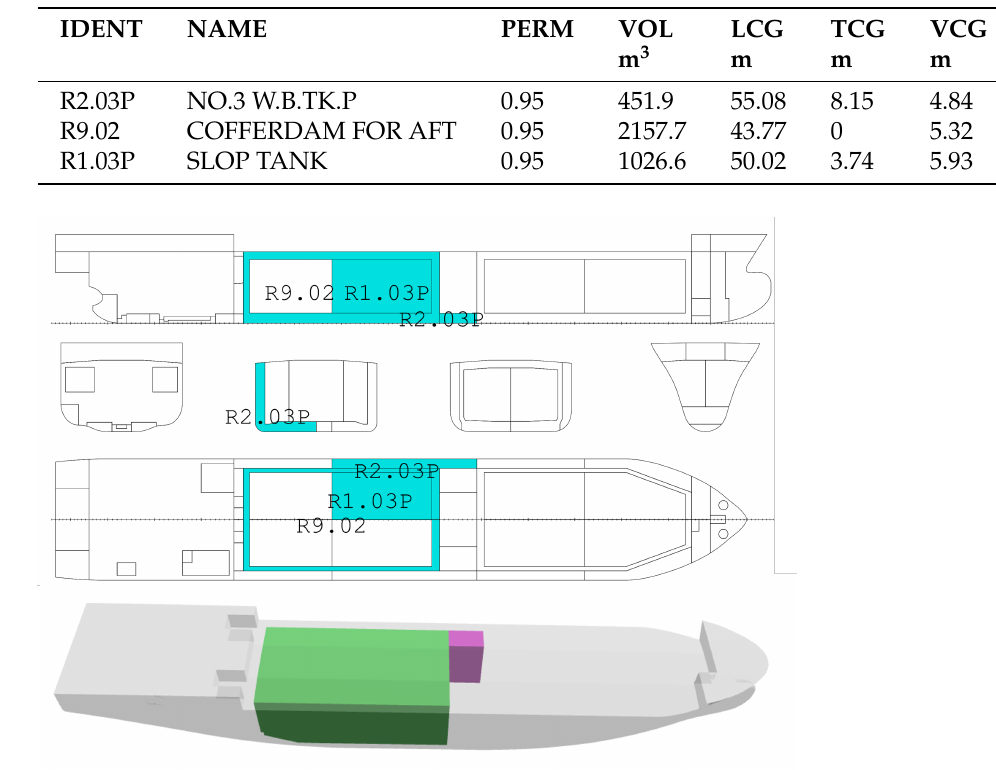
Table 9. Damaged compartments of DAM10.